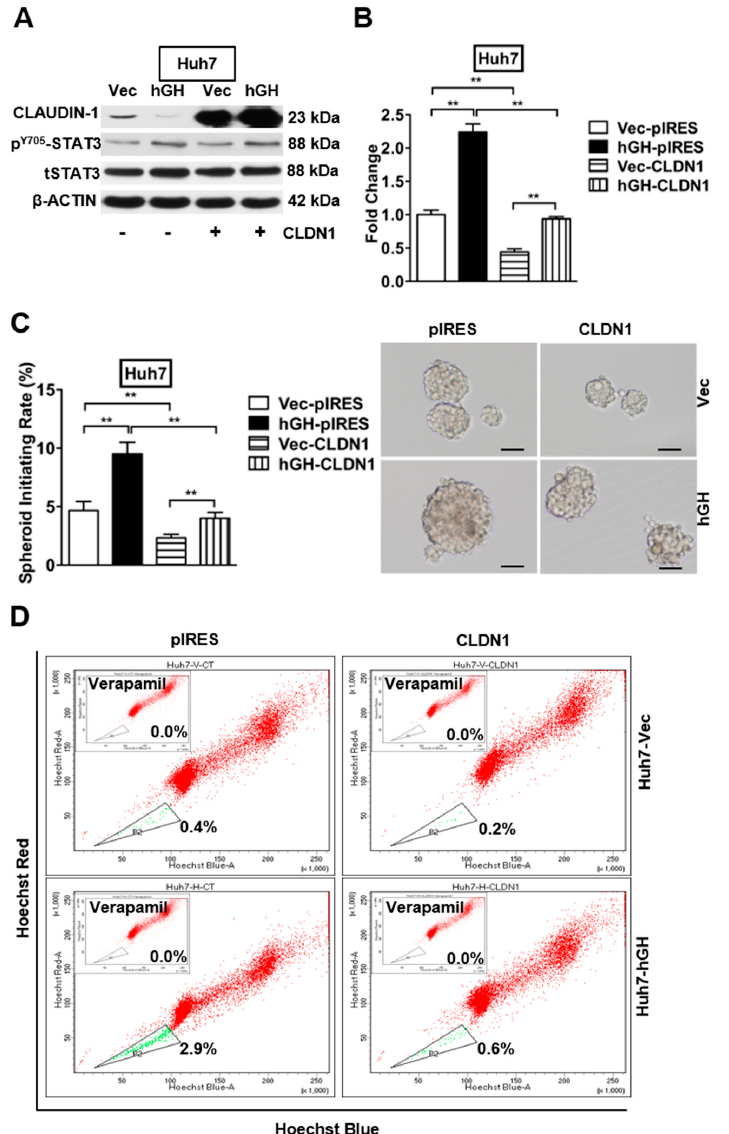
Figure 6. Forced expression of CLAUDIN-1 abrogated hGH promoted invasive and CSC-like properties in HCC cells. ( A ) Western blot analysis of CLAUDIN-1 expression and STAT3 activity in Huh7-Vec/hGH cell lines transfected with CLAUDIN-1 expressing plasmids (pIRES-CLDN1) or control plasmids; ( B ) Transwell assay to determine the invasive potential of Huh7-Vec/hGH cells tranfected with pIRES-CLDN1 or control plasmids. ** p < 0.01; ( C ) Suspension culture to determine the spheroid formation of Huh7-Vec/hGH cells transfected with pIRES-CLDN1 or control plasmids. ** p < 0.01; bar, 100 µm; ( D ) Hoechst 33,342 efflux assay to determine SP of Huh7-Vec/hGH cells tranfected with pIRES-CLDN1 or control plasmids. Verapamil was used to establish the baseline fluorescence of these cells. The side population within the triangle is represented by green dots, while the non-side population is represented by red dots.